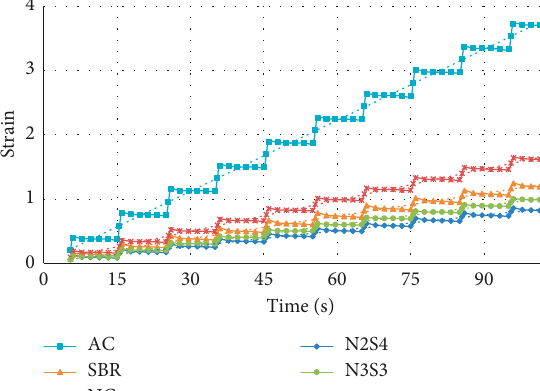
Figure 7: RCR test.